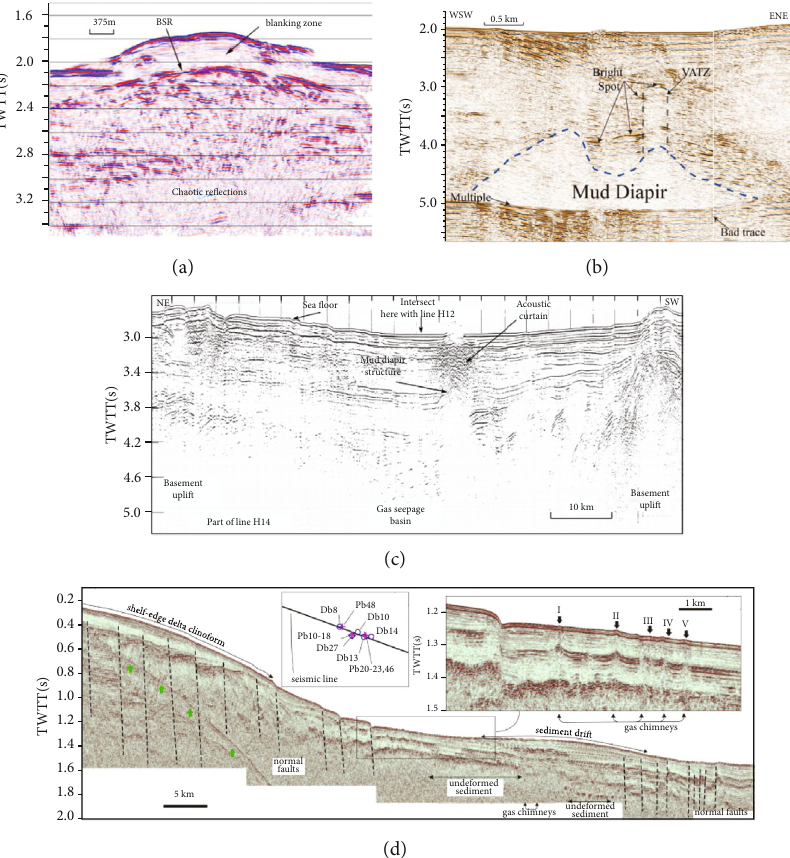
Figure 3: The representative seismic sections in the Okinawa Trough showing the features associated with the vertical migration pathways for the methane-rich pore fl uids. (a) Blanking zone and mud diapir (from [11]). (b) Bright spot and mud diapir (from [12]). (c) Acoustic curtain and mud diapir (from [10]). (d) Gas chimney (from